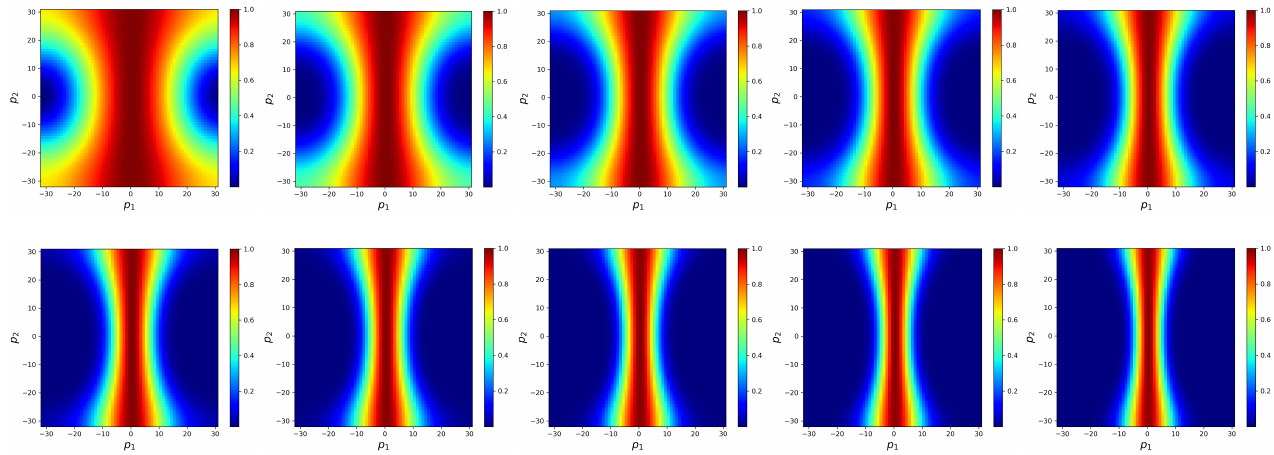
Figure 3. Distribution of convergence factor for Cheby-semi ( m = 10) when ξ = 10 − 3 , θ = 0. After training, we choose θ = 0, ξ = 10 − 1 , . . . , 10 − 6 for testing and generate 10 random right-hand functions for each parameter. The iteration is terminated when the relative residual is less than 10 − 6 . We use “mean ± std” to show the mean and standard deviation of the iterations over the test set as in [20].